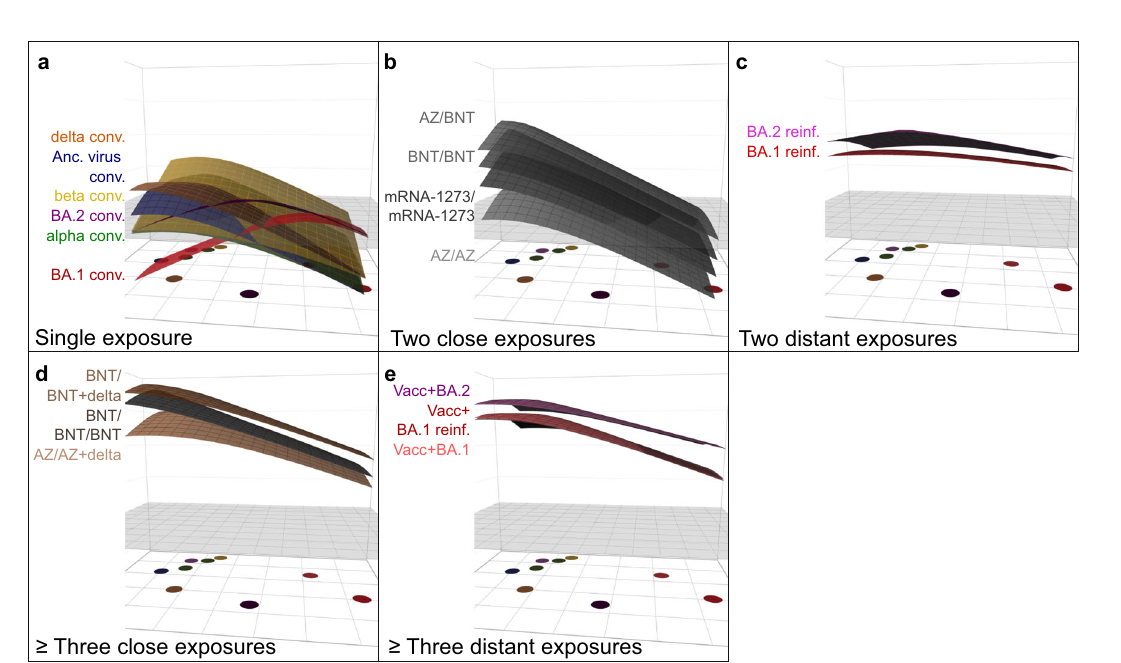
Fig. 3 | Antigenic map of SARS-CoV-2 variants constructed from single expo- sure convalescent and double vaccinated sera. Virus variants are shown as colored circles, sera as open squares with the color corresponding to the infecting variant.Trianglesindicateserapositionedoutsidethecentralmapareaandpointin thedirectionwherethecorrespondingserumispositioned.Vaccineseraareshown in grey tones (from dark to light: mRNA-1273/mRNA-1273 n =10, BNT162b2/ BNT162b2 (BNT/BNT) n =11, ChAdOx-S1/BNT162b2 (AZ/BNT) n =10, ChAdOx-S1/ ChAdOx-S1(AZ/AZ) n =10).Thealpha+E484Kvariantisshownassmallercircledue to its additional substitution compared to the alpha variant. The x- and y-axis represent antigenic distances with one grid square corresponding to one two-fold serumdilutionoftheneutralizationtiter.Themaporientationwithinx-andy-axisis